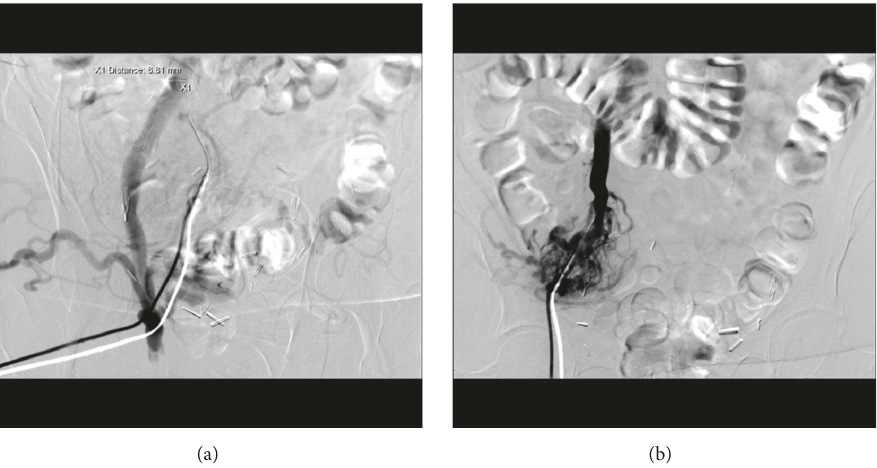
Figure 2: Fluoroscopic images of right lower quadrant. (a) Contrast injection of the peristomal varix and opacification of the right iliac vein. (b) Opacification of the peristomal varices and the right iliac vein.